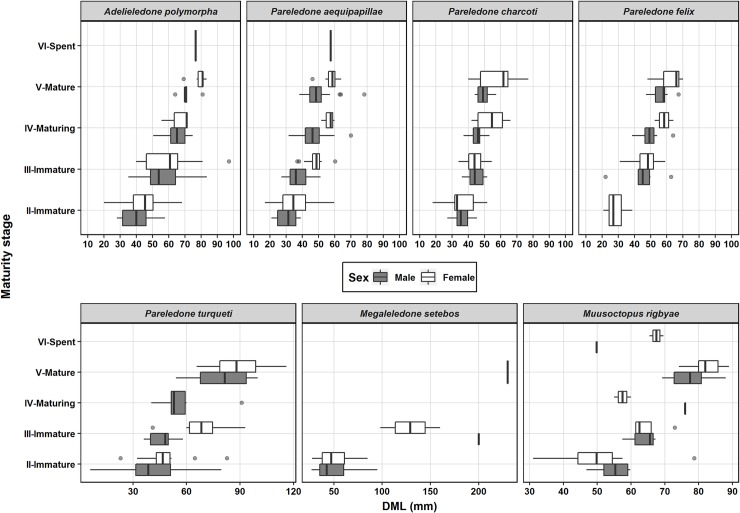
Size distribution at different maturity stages of the most numerous species. Grey circles are outliers.